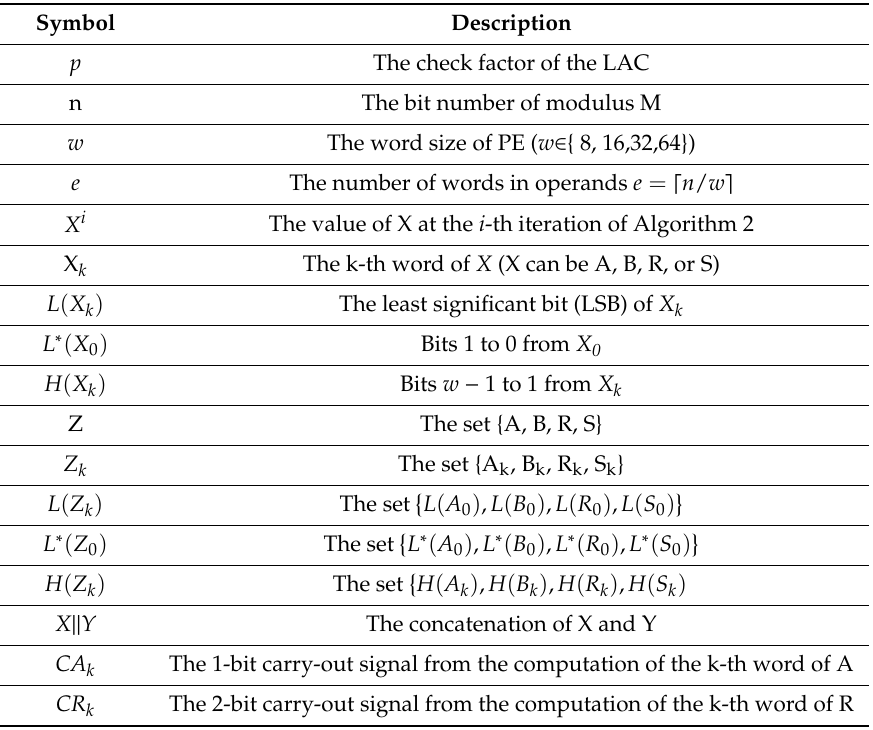
Table 1. Parameter